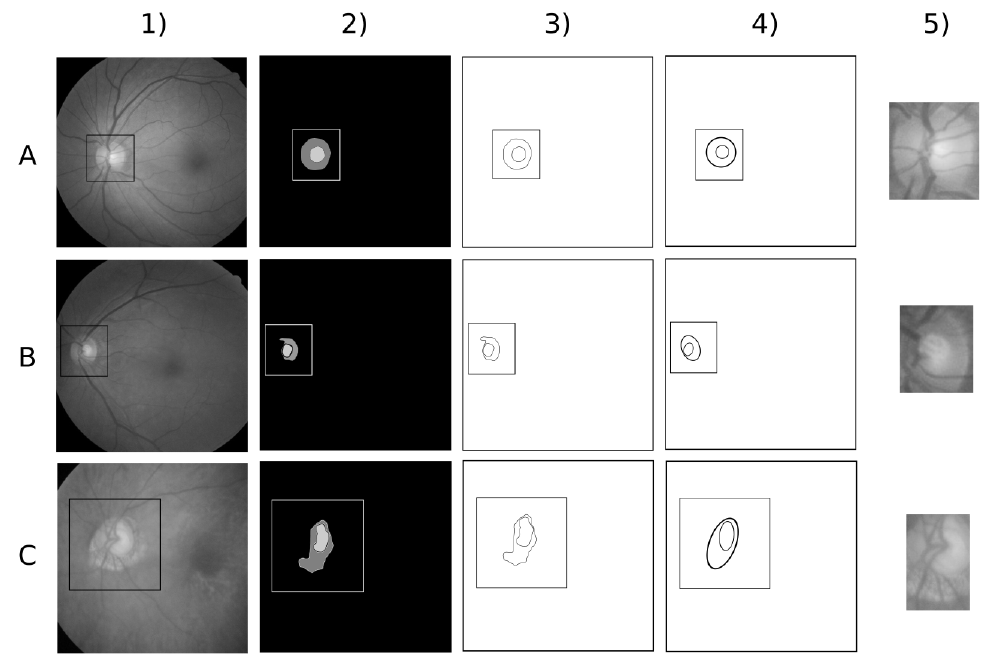
Figure 9. Performance of segmentation network (U-Net) on external dataset LAG. Columns A, B, and C represent examples of the best, mild, and worst scenarios, respectively. Each row, in this case, shows a step into the OD segmentation process, (1) input CFP, (2) output mask by U-Net, (3) output from contour filter algorithm, (4) ellipse-fitting output for detected contours, and (5) final OD